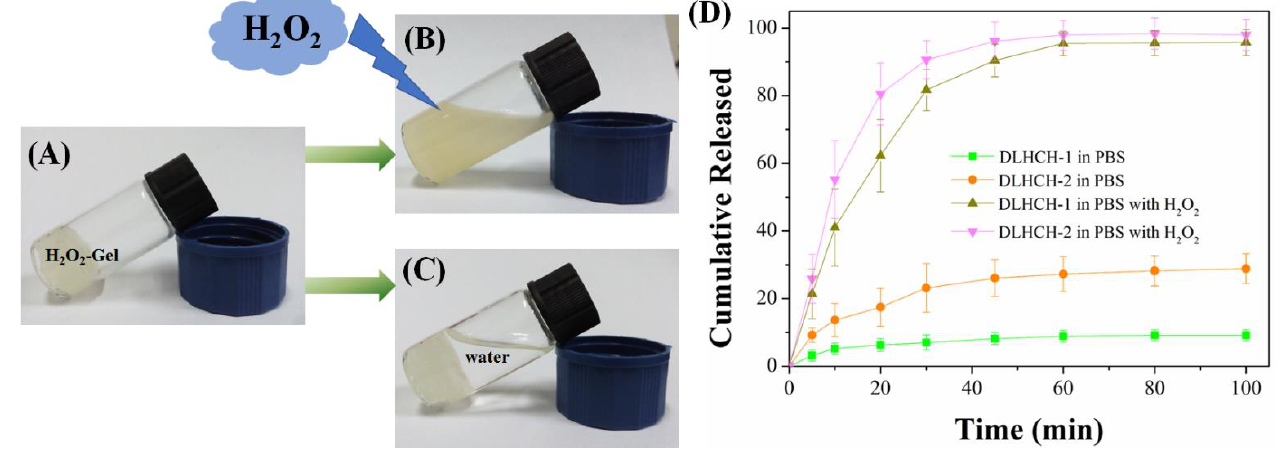
Figure 2. The H 2 O 2 -responsive behaviour of 1,4-phenylenebisdiboronic acid-crosslinked hydrogels reported by our group ( A ): H 2 O 2 -Gel in a transparent vial; ( B ): H 2 O 2 -Gel immersing in H 2 O 2 aqueous solution for 100 min; ( C ): H 2 O 2 -Gel immersing in aqueous solution for 100 min; ( D ): the drug release profiles of DLHCH-1 and DLHCH-2) (Reprinted/adapted with permission from Ref. [50]. Copyright year: 2022, copyright owner’s name: Hailei Zhang)